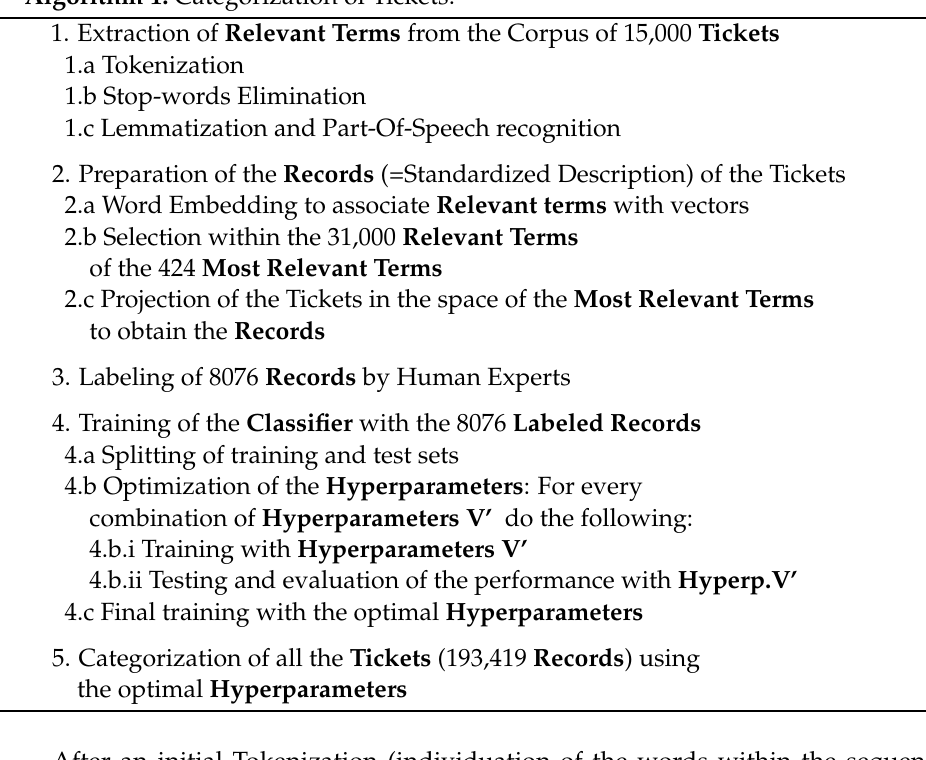
Algorithm 1: Categorization of